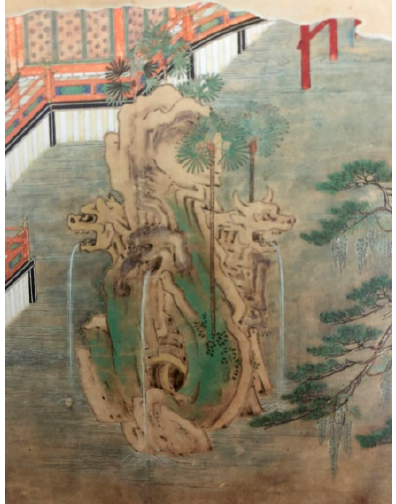
Figure 3. A garden fountain modeled on the Anavatapta Lake, from the Illustrated Life of Xuanzang . (Nara Kokuritsu Hakubutsukan 2011), p. 91.